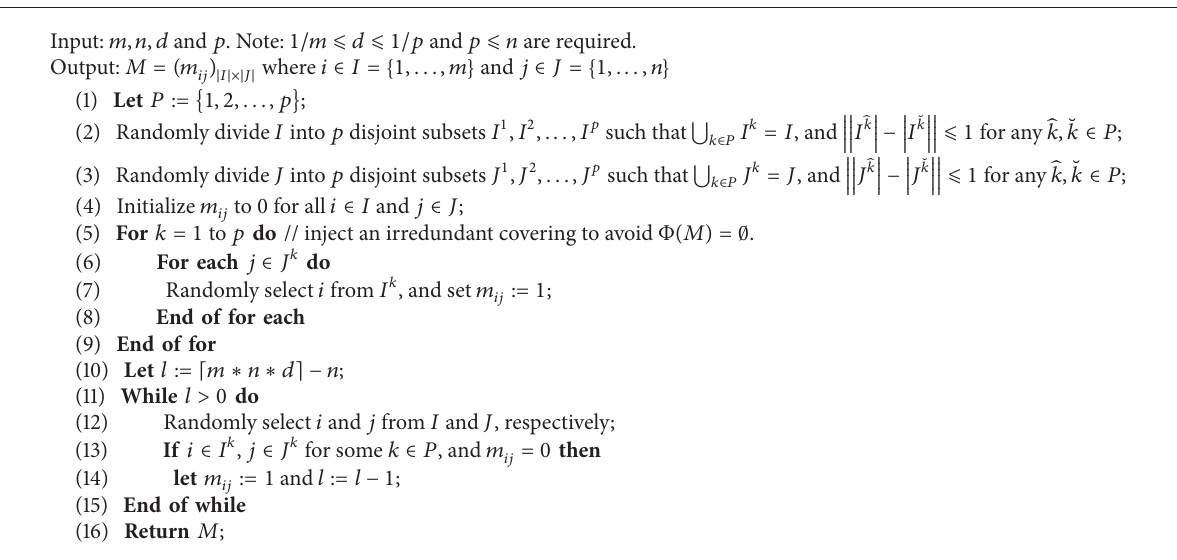
Algorithm 2: Procedure for generating test matrices.